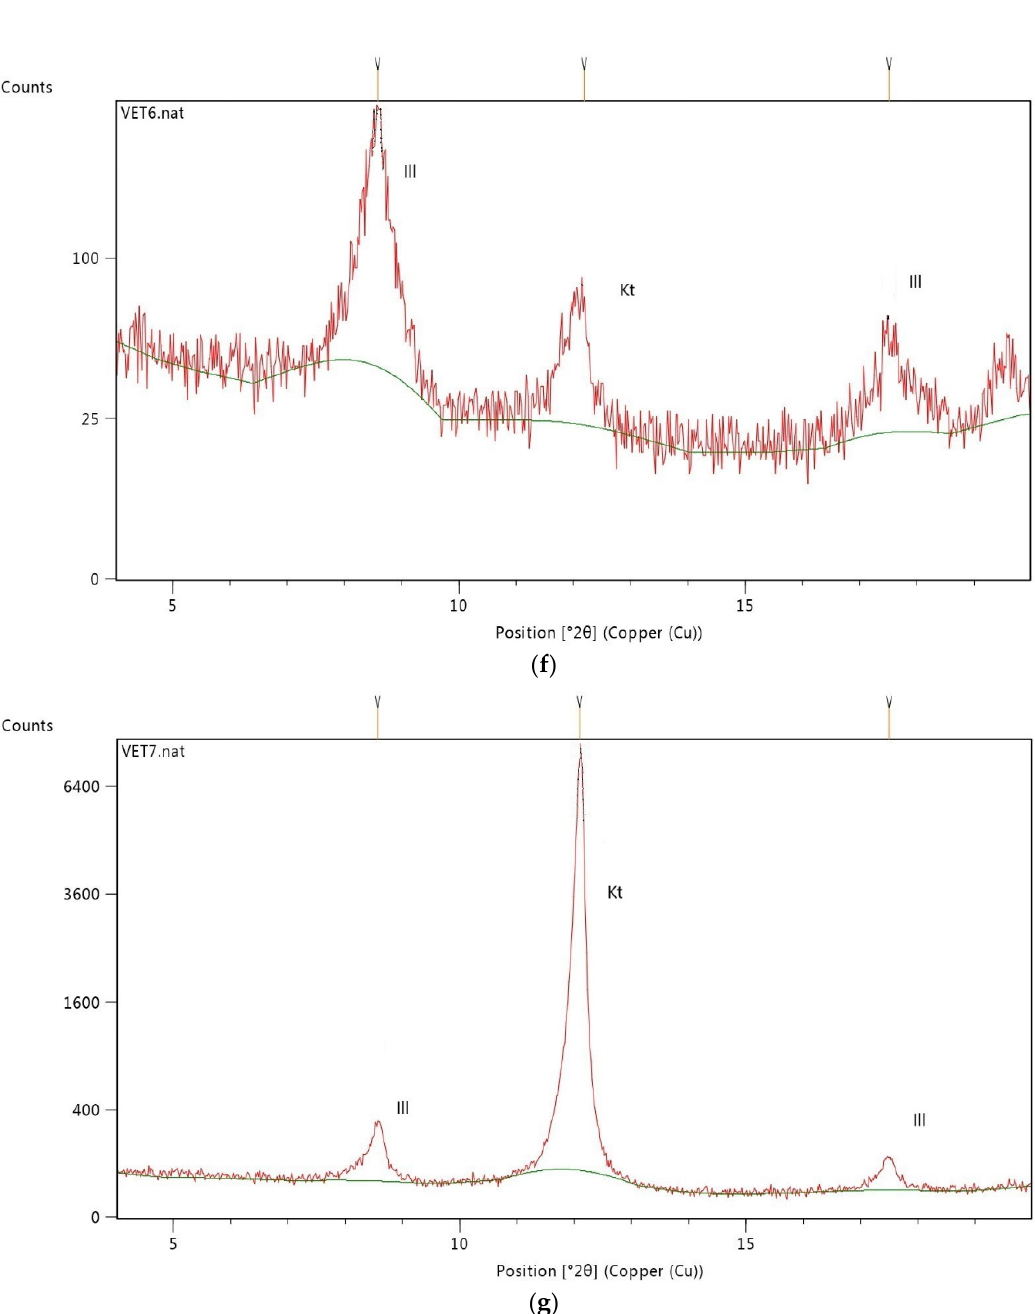
Table 2. Mineralogical composition (%).